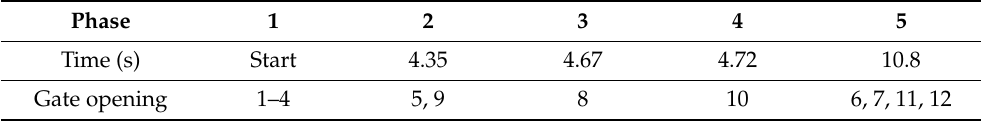
Table 4. Proposed sequence of the filling valve